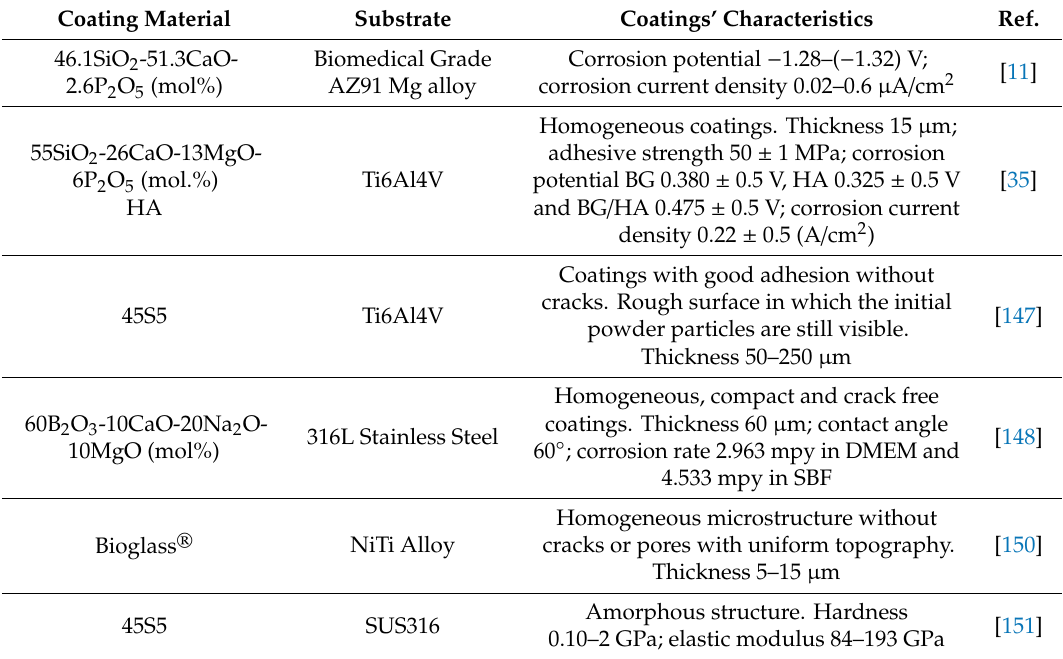
Table 4. Summary of bioactive glass coatings obtained by